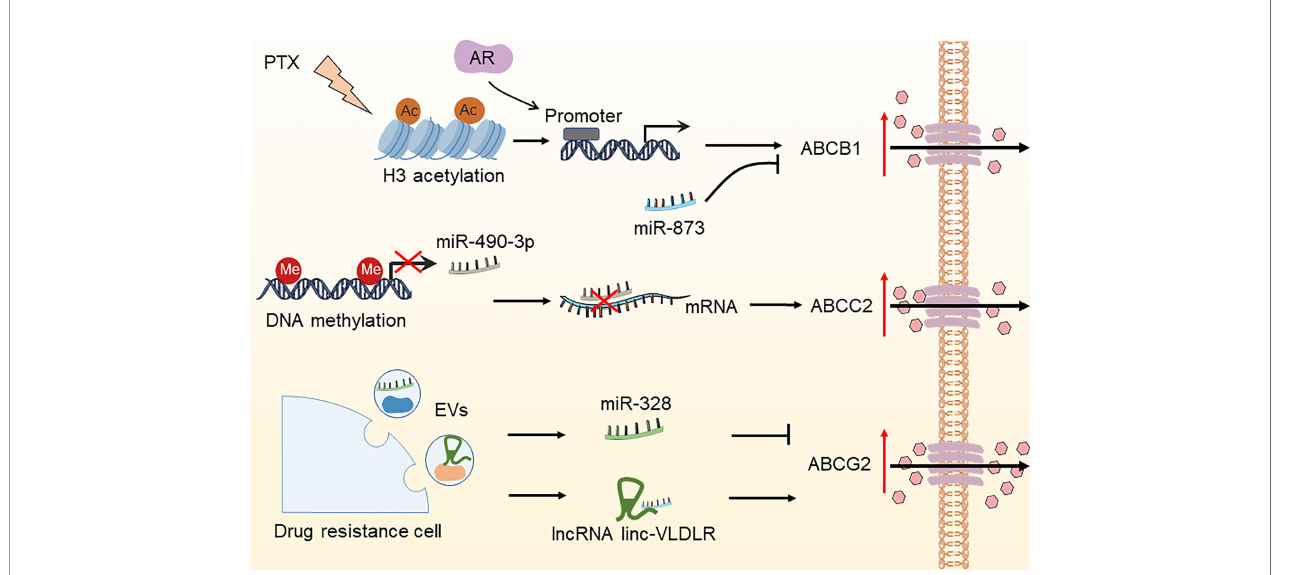
FIGURE 3 | Epigenetic modi fi cations regulate the expression of ABC transporters in OC. The DNA methylation of miR-490-3p, increased histone H3 acetylation due to paclitaxel treatment, miR-328, and lncRNA linc-VLDLR in EVs have been reported to increase drug ef fl ux by regulating the expression of ABCC2, ABCB1, and ABCG2, thereby leading to OC drug resistance. PTX, paclitaxel; AR, androgen receptor; EVs, extracellular